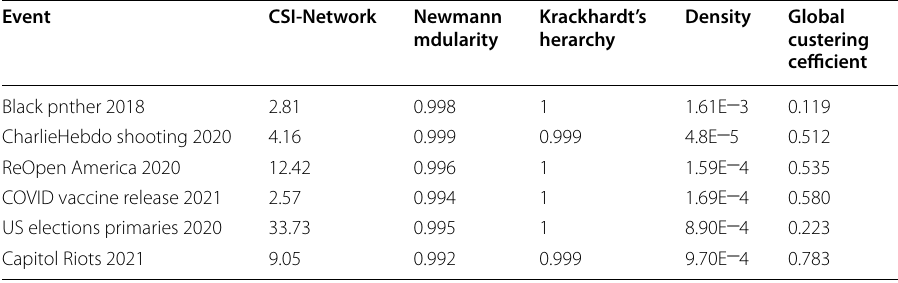
Table 6 Comparison of CSI-Network scores against network mModularity metrics derived from the synchronized network